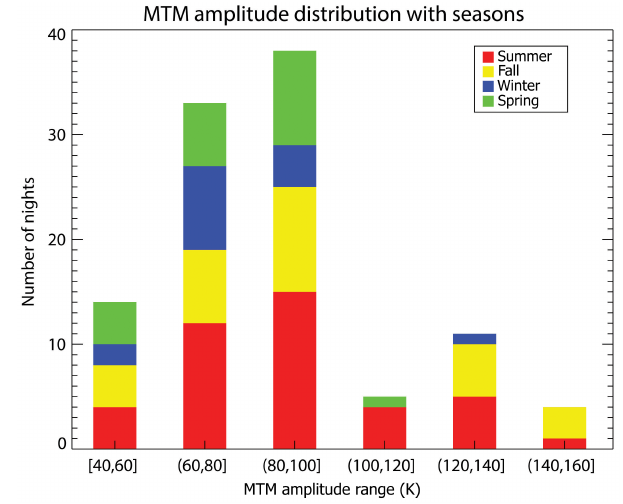
Figure 10. MTM statistical distribution with regard to season and maximum amplitude for all the stations. The more frequent MTM amplitudes are found in the (60, 80] and (80, 100] ranges with 33 and 39 nights, respectively. MTM events with large amplitudes ex- ceeding 120K are occasionally seen (15